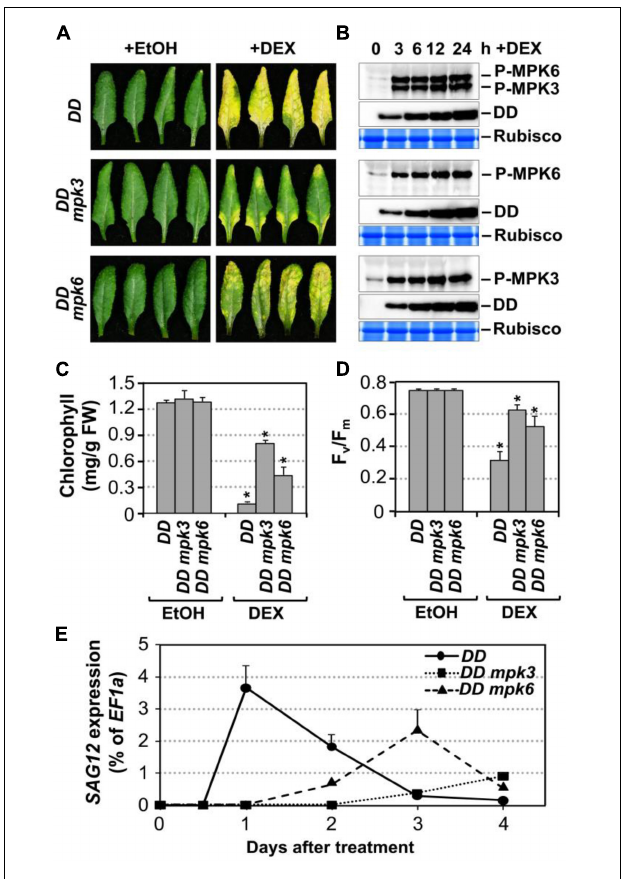
FIGURE 2 | Leaf senescence in gain-of-function DD plant is dependent on endogenous MPK3 and MPK6. (A) Fully expanded leaves from 4-week-old DD , DD mpk3 , DD mpk6 plants were detached and their petioles were inserted into 0.6% agar medium with DEX (100 nM) or EtOH (solvent control). Photos were taken 4 days after treatment. (B) MAPK activation (top) and DD protein induction (middle) in DD , DD mpk3 , and DD mpk6 plants after DEX treatment were detected by immunoblot analysis using anti-pTEpY and anti-Flag antibody, respectively. Coomassie brilliant blue staining of duplicated gels were used to confirm equal loading (bottom). (C,D) Measurement of chlorophyll content (C) and F v /F m (D) in leaves shown in (A) . Asterisks indicate a significant difference ( P ≤ 0.001). Values are means ± SD, n = 10. (E) RT-qPCR analysis of SAG12 expression in leaves at indicated times after DEX treatment. Gene expression was calculated using the double (cid:49) Ct method and EF1 α was used as a reference. Values were means ± SD, n =